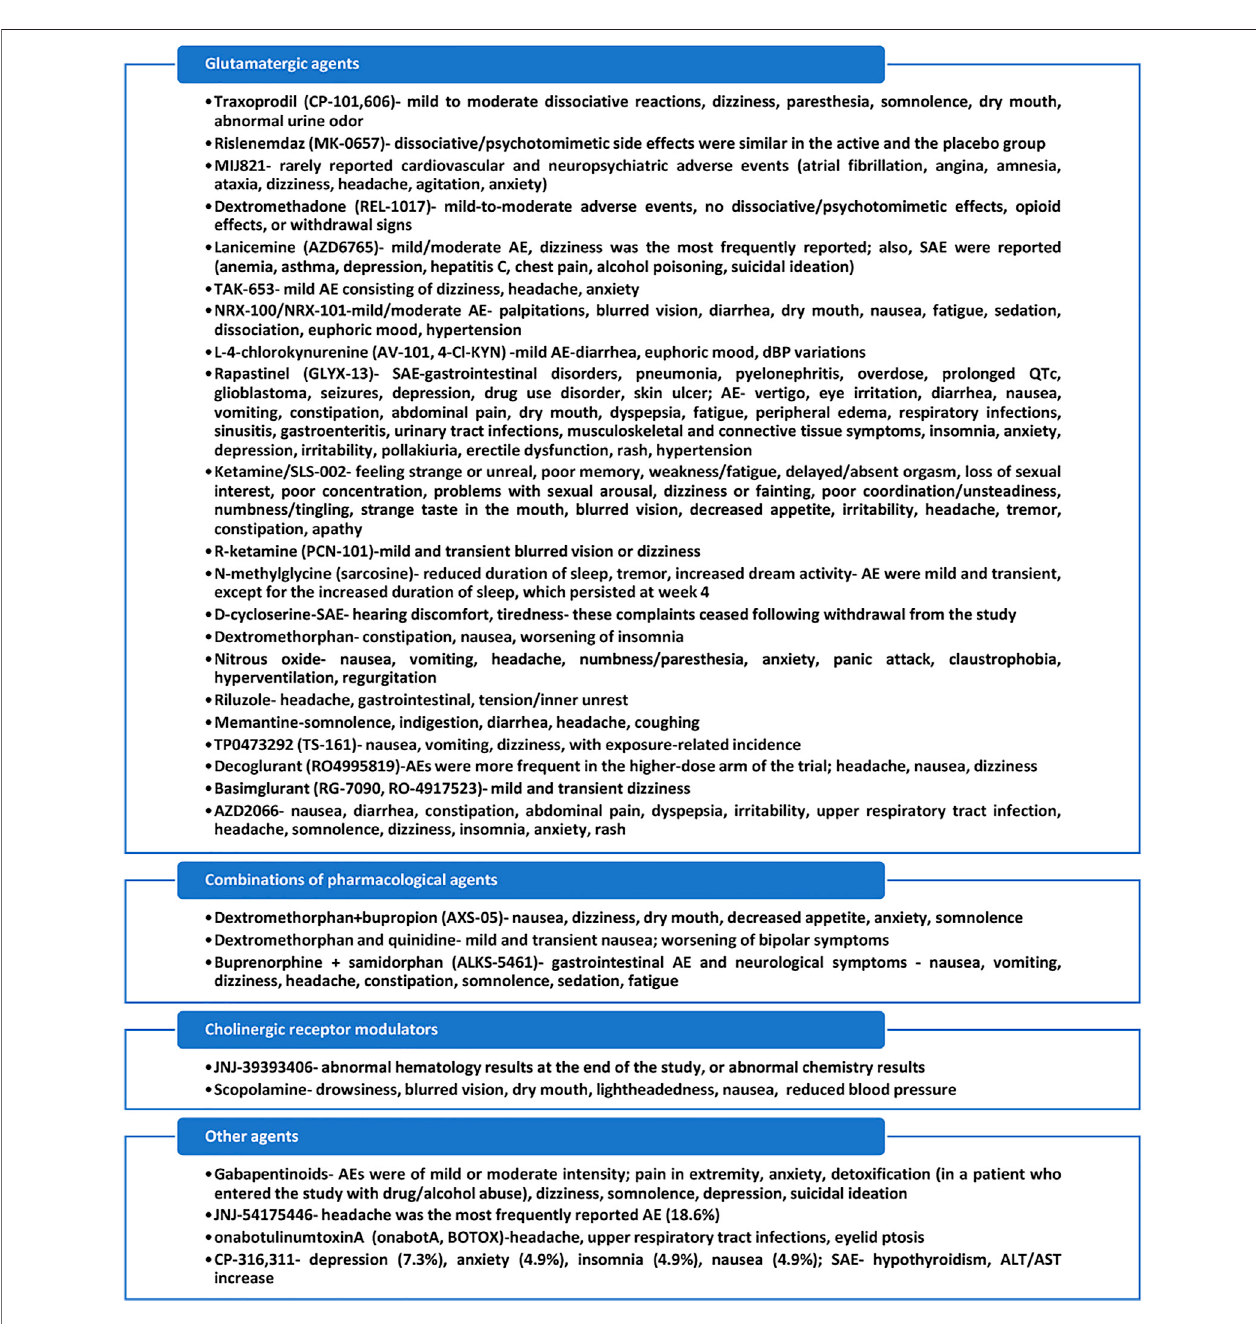
FIGURE 5 | Main adverse events identi fi ed in clinical trials exploring new antidepressant agents. AE, adverse events; dBP, diastolic blood pressure; SAE, severe adverse events. Based on data from Preskorn et al. (2008); Ibrahim et al. (2012); Ghaemi et al. (2021); Fava et al. (2022); Sanacora et al. (2017); O ’ Donnell et al. (2021); NLM, NCT02974010; Park et al. (2020); NLM, NCT02192099; Lapidus et al. (2014); Leal et al. (2021); Huang et al. (2013); Heresco-Levy et al. (2013); Majeed et al. (2021); Nagele et al. (2015); Zarate et al. (2004); NLM, NCT00305578; Umbricht et al. (2020); Quiroz et al. (2016); NLM, NCT01145755; Axsome Therapeuticals (2019); Axsome Therapeuticals (2020); Kelly and Lieberman (2014); Fava et al. (2016); NLM, NCT03188185; Davidson et al. (2021); Drevets and Furey (2010); NLM, NCT03386448; Arnold et al. (2015); Timmers et al. (2018); Brin et al. (2020); Binneman et al. (2008).